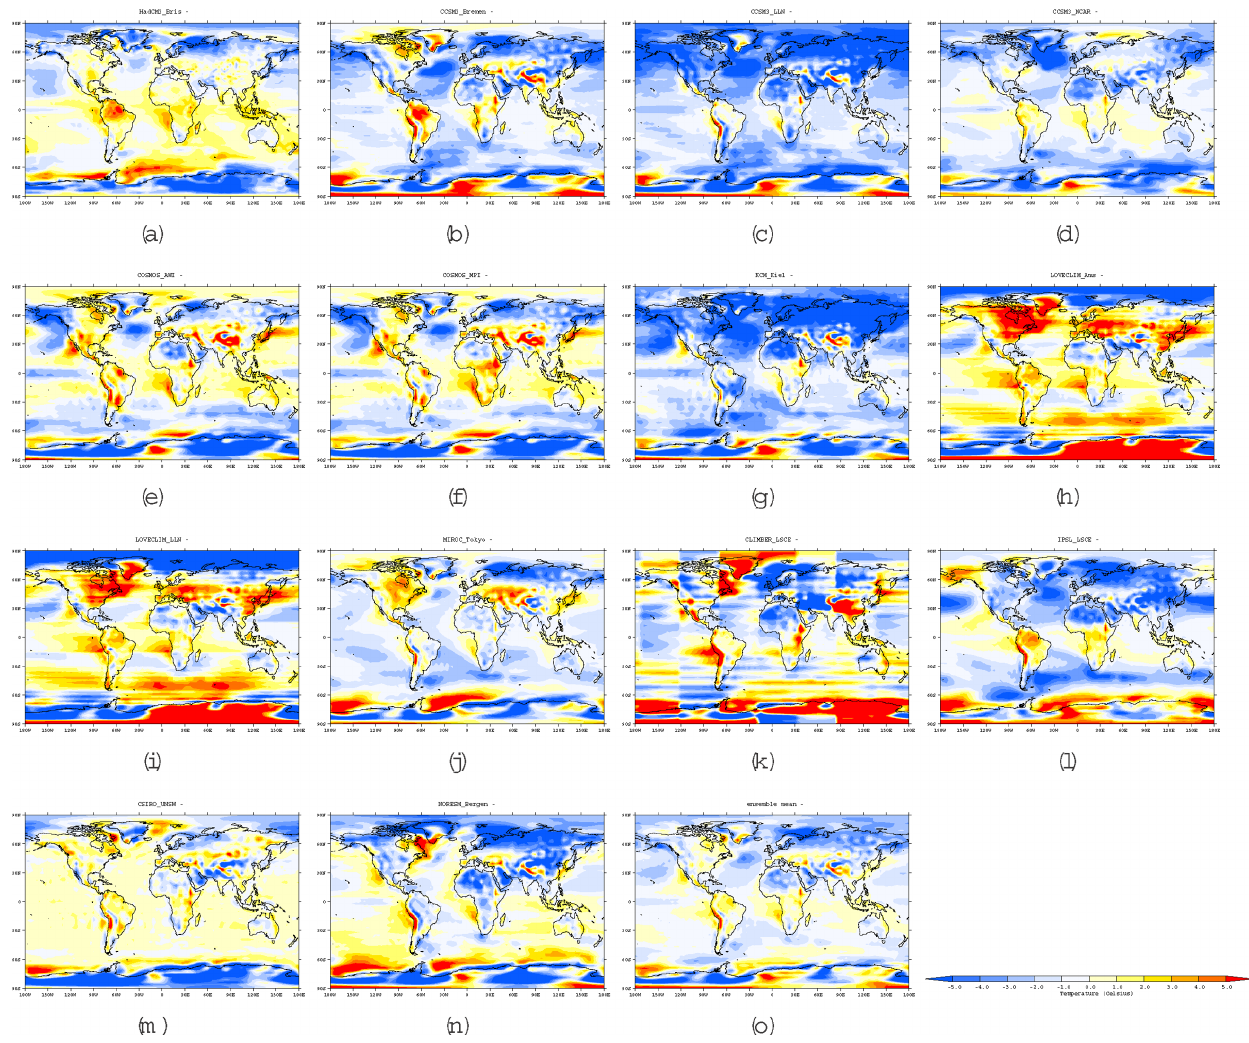
Fig. 4. “Error” in the pre-industrial control simulation of each model, relative to NCEP reanalyses (Kalnay et al., 1996), for surface air temperature. (a) HadCM3 Bris, (b) CCSM3 Bremen, (c) CCSM3 LLN, (d) CCSM3 NCAR, (e) COSMOS AWI, (f) COSMOS MPI, (g) KCM Kiel, (h) LOVECLIM Ams, (i) LOVECLIM LLN, (j) MIROC Tokyo, (k) CLIMBER LSCE, (l) IPSL LSCE, (m) CSIRO UNSW, (n) NORESM BCCR, (o) ensemble mean of models (a) – (n) . Note that the observations are for modern (1948–1987), whereas the models are designed to represent pre-industrial. All data are interpolated onto a 96 × 73 resolution before calculating the difference, model minus data. The RMS values for each model simulation are given in Table